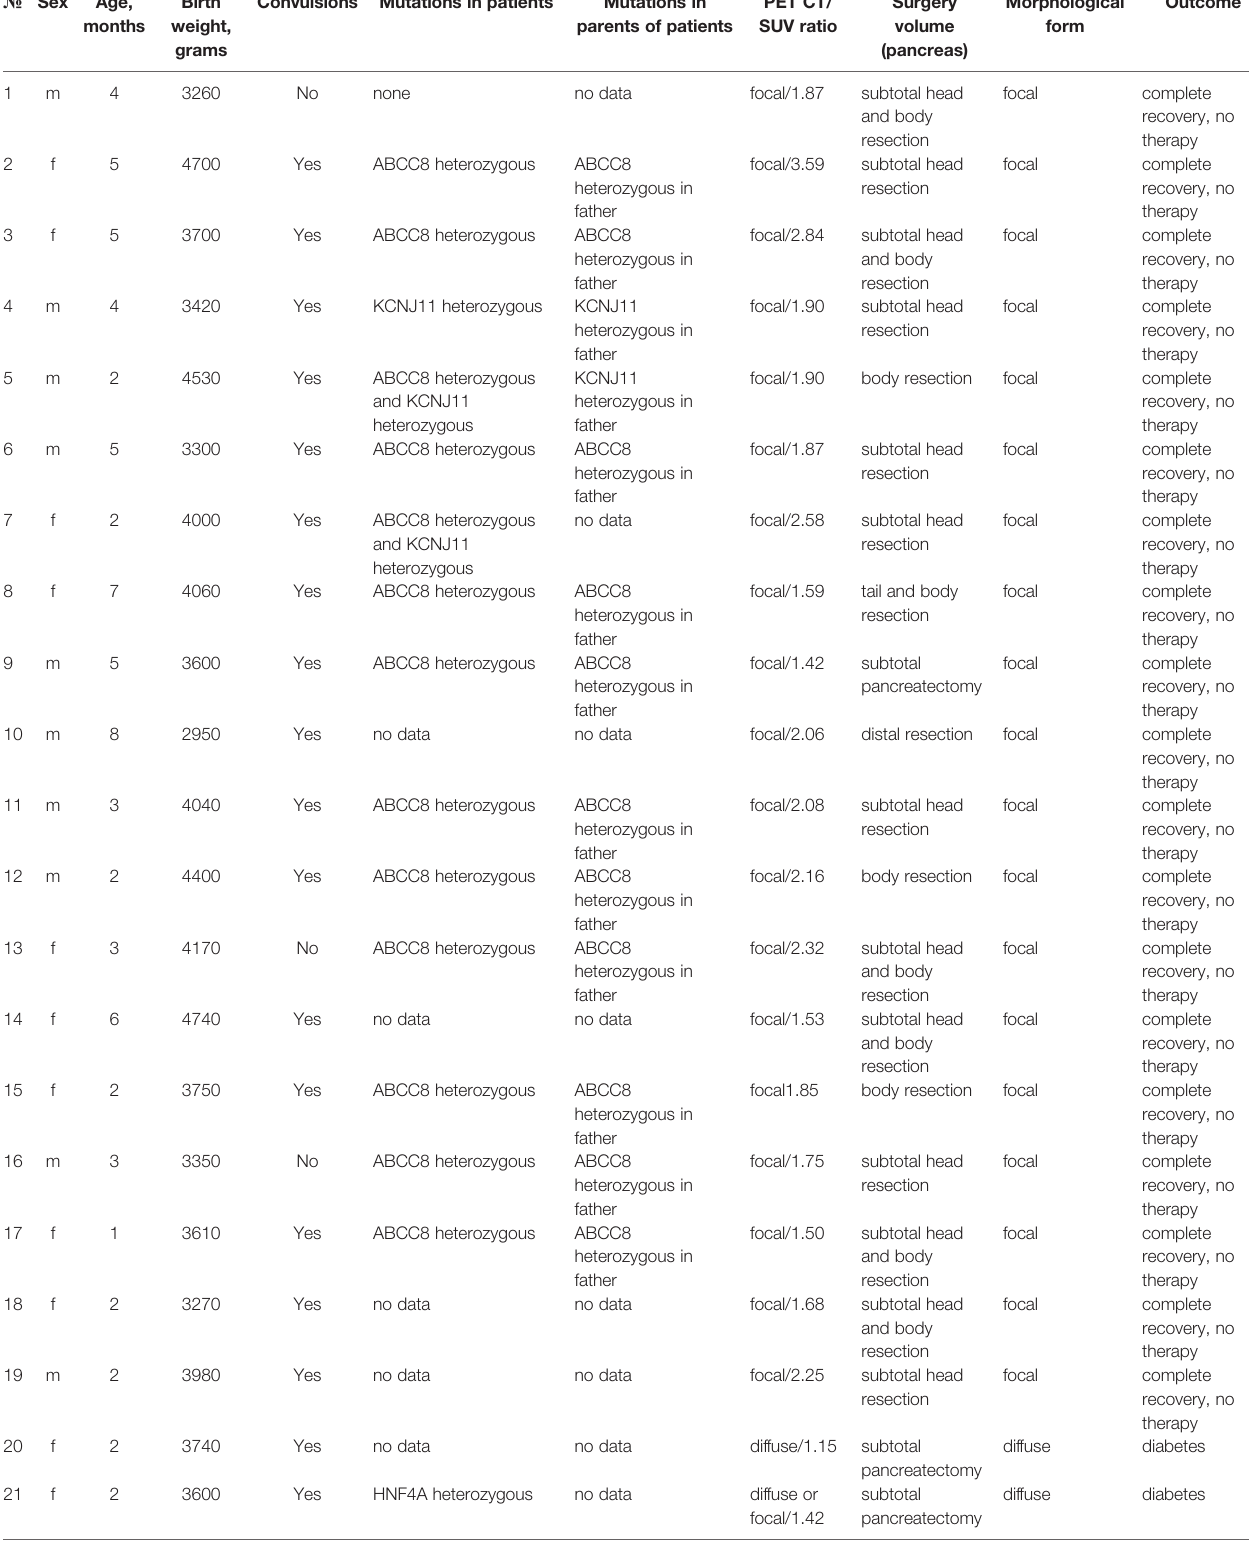
TABLE 1 | Patient clinical and morphological